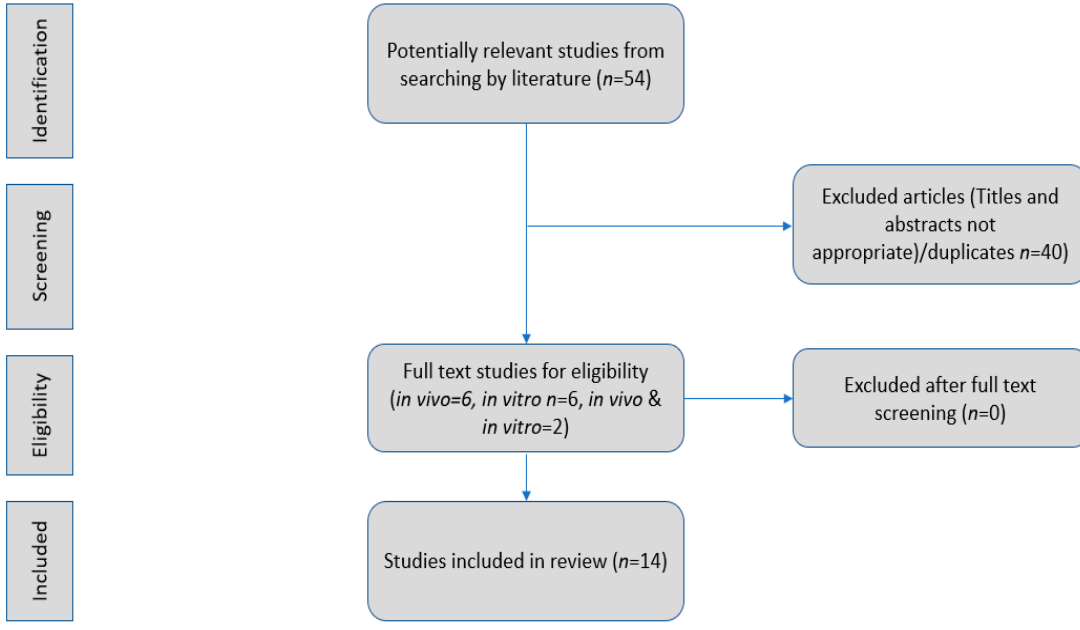
Figure 1. Flow chart. Identification and selection of the studies.